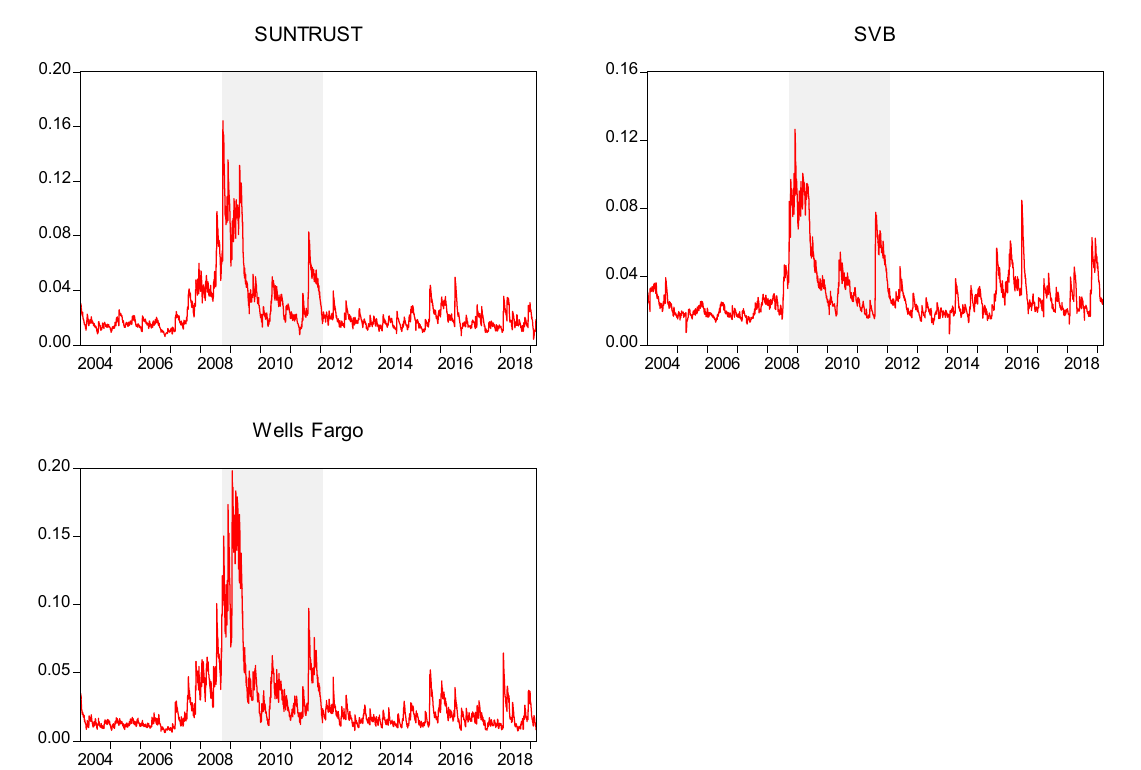
Figure A2. Marginal Expected Shortfall. Source: Author’s computation. The shaded area represents the crisis period.